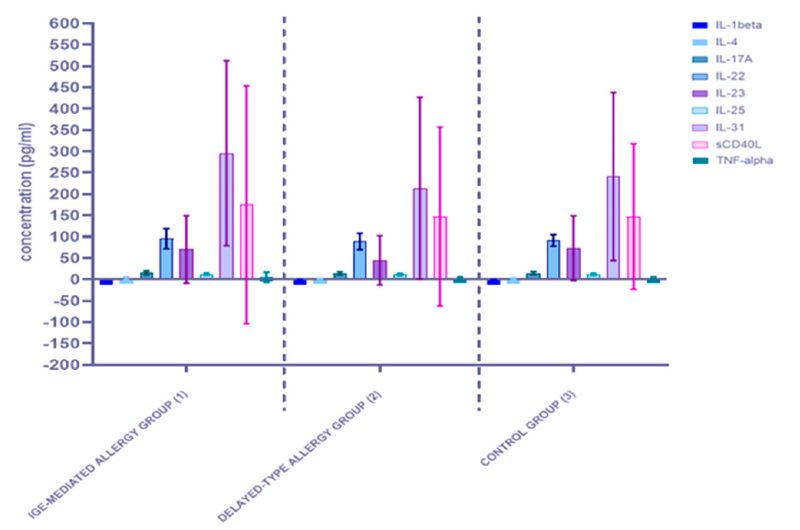
Figure 3. Comparison of serum cytokine concentrations between the three studied groups: the IgE-mediated allergy group (1), the delayed-type allergy group (2), and the control group (3).